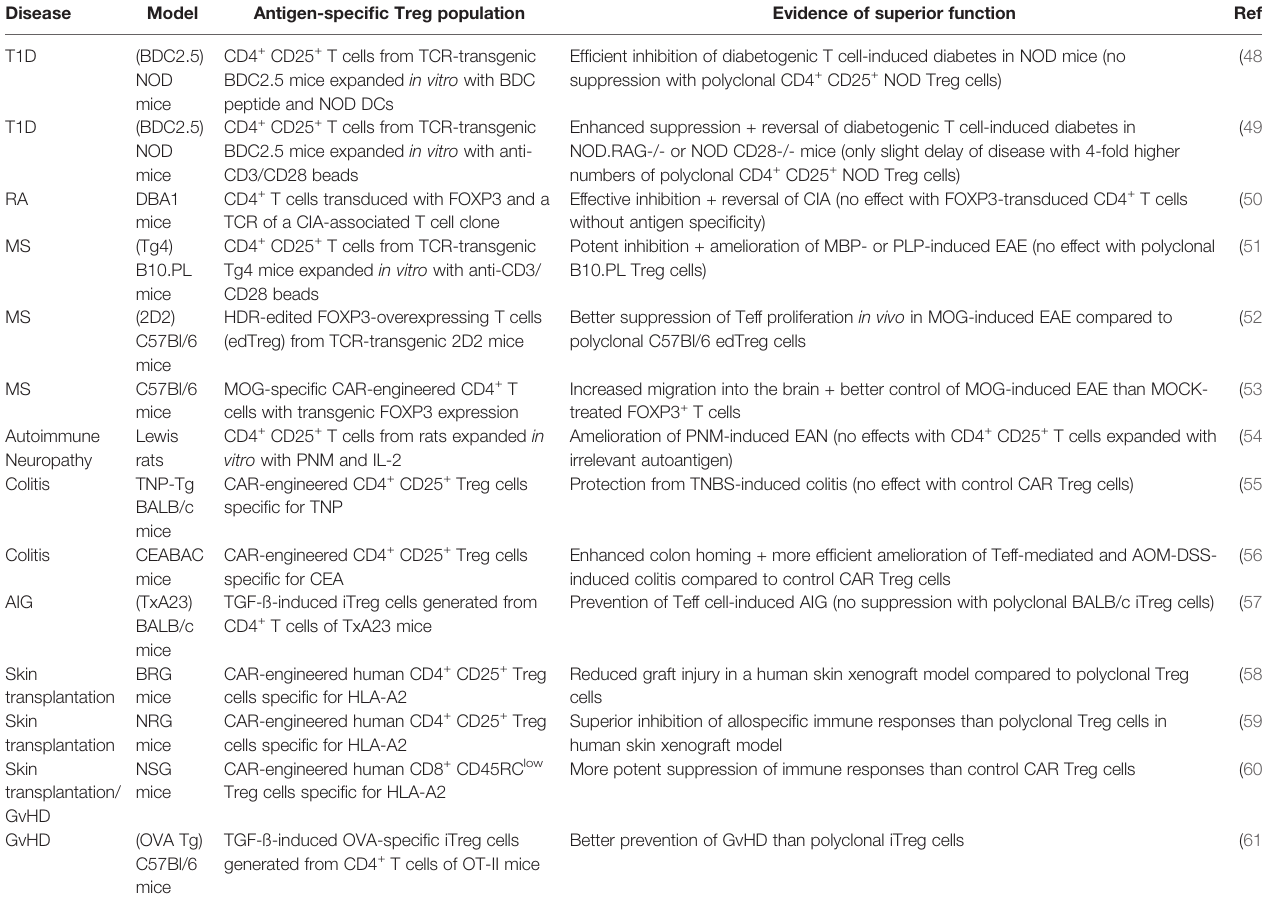
T1D, type 1 diabetes; NOD, non-obese diabetic; RA, rheumatoid arthritis; MS, multiple sclerosis; AIG, autoimmune gastritis; TCR, T cell receptor; DCs, dendritic cells; CIA, collagen- induced arthritis; HDR, homology-directed repair; MOG, myelin oligodendrocyte glycoprotein; MBP, myelin basic protein; PLP, proteolipid protein; EAE, experimental autoimmune encephalomyelitis; CAR, chimeric antigen receptor; PNM, peripheral nerve myelin; EAN, experimental autoimmune neuritis; TNP, 2,4,6-trinitrophenol; TNBS, 2,4,6-trinitrobenzene sulphonic acid; CEA, carcinoembryonic antigen; AOM-DSS, azoxymethane-dextran sodium sulfate; TGF-ß, transforming growth factor beta; HLA, human leukocyte antigen; GvHD, graft versus host disease; OVA,